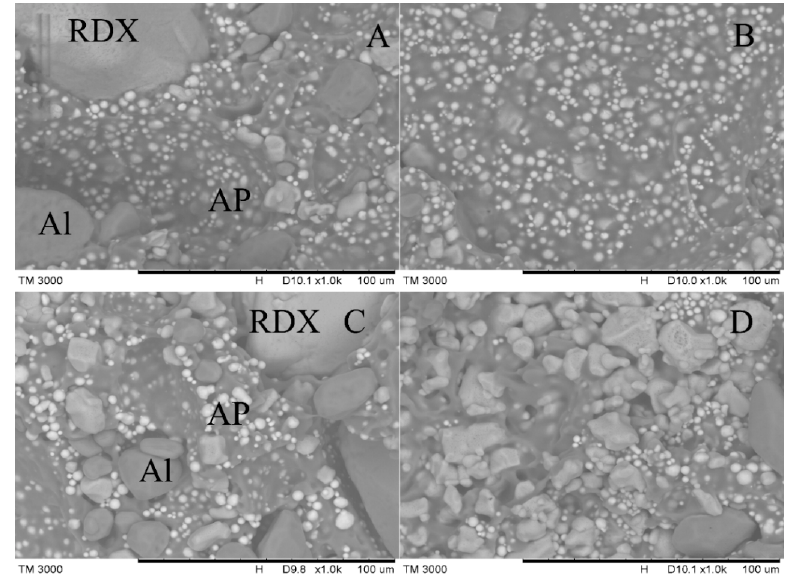
Figure 9. SEM photos of the surface morphology propellants: ( A,B ), ATPET& N100- g -GAP, ( C,D ) ATPET&GAP ( Mn = 4000 g/mol).